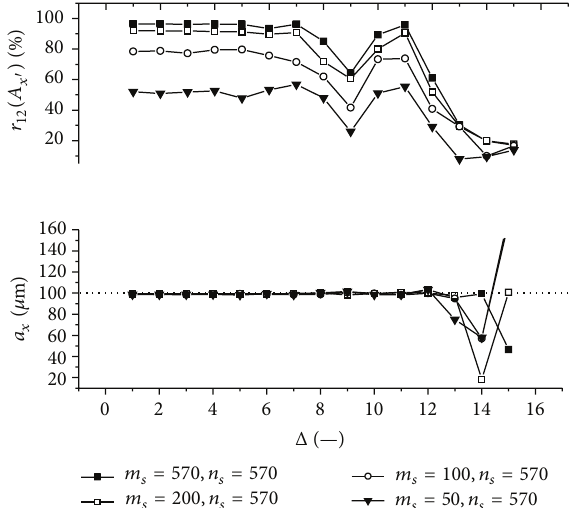
Figure 14: The evaluated object’s translation component 𝑎 𝑥 as well as the maximum 𝑟 12 (𝐴 𝑥 󸀠 ) of the 1D normalized cross-correlation function of intensity signals 𝐼 1 and 𝐼 2 acquired from decimated 2D intensity signals of various size as a function of the factor Δ . Mean speckle sizes are 𝛼 𝑥 󸀠 = 133.6 𝜇 m and 𝛼 𝑦 󸀠 = 117.7 𝜇 m. The object is translated by 𝑎 𝑥 = 100 𝜇 m and 𝑎 𝑦 = 100 𝜇